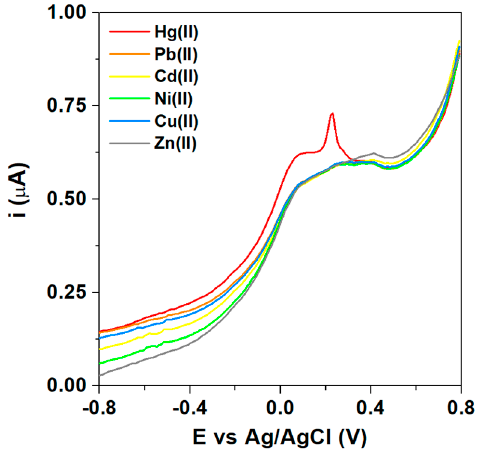
Figure 6. Differential pulse voltammetry (DPV) curves recorded on a GC|click| L modified electrode Figure 6. Di ff erential pulse voltammetry (DPV) curves recorded on a GC | click | L modified electrode after 10 min accumulation in acetate buffer (pH 4.5) containing 5 × 10 − 8 M of various heavy metal ions. after 10 min accumulation in acetate bu ff er (pH 4.5) containing 5 × 10 − 8 M of various heavy metal